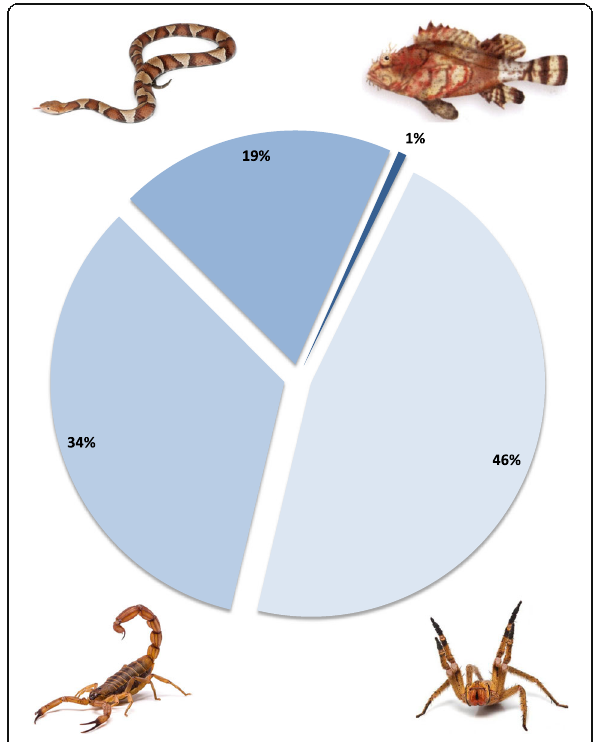
Fig. 1 Fish venoms in the literature. Comparison between the number of entries (%) obtained through a search for sequences of bioactive proteins from spiders, scorpions, snakes and fish in the UniProtKB database. Entry terms: spider/scorpion/snake/fish: organism; toxins: keyword